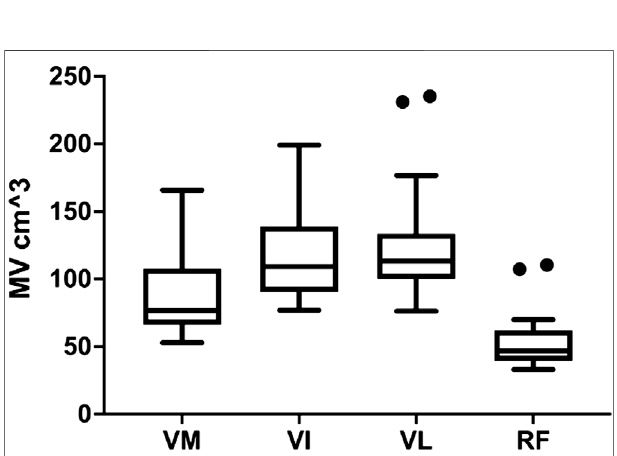
FIGURE 3 | Bland-Altman graph depicting the difference between the two investigators in respect to total muscle thickness measured by ultrasound.